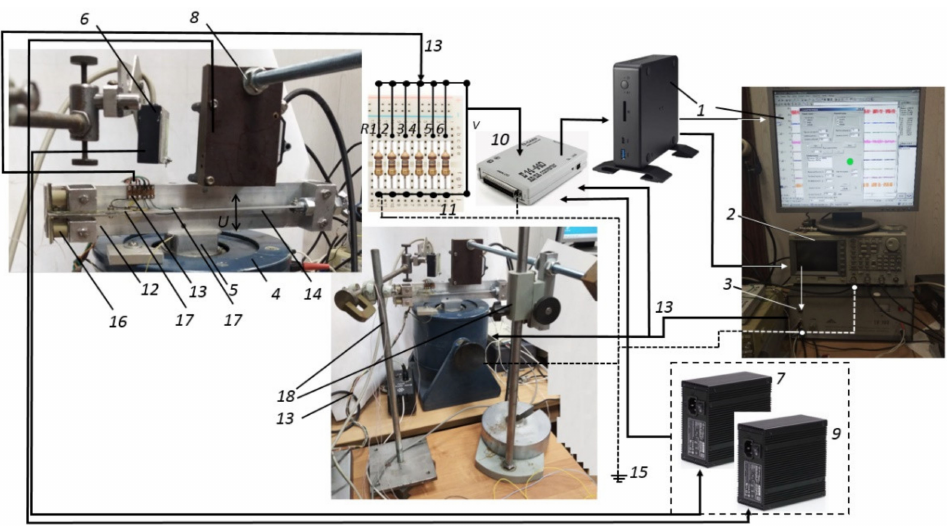
Figure 10. General view of laboratory test setup LTS -01 for studying the output parameters of